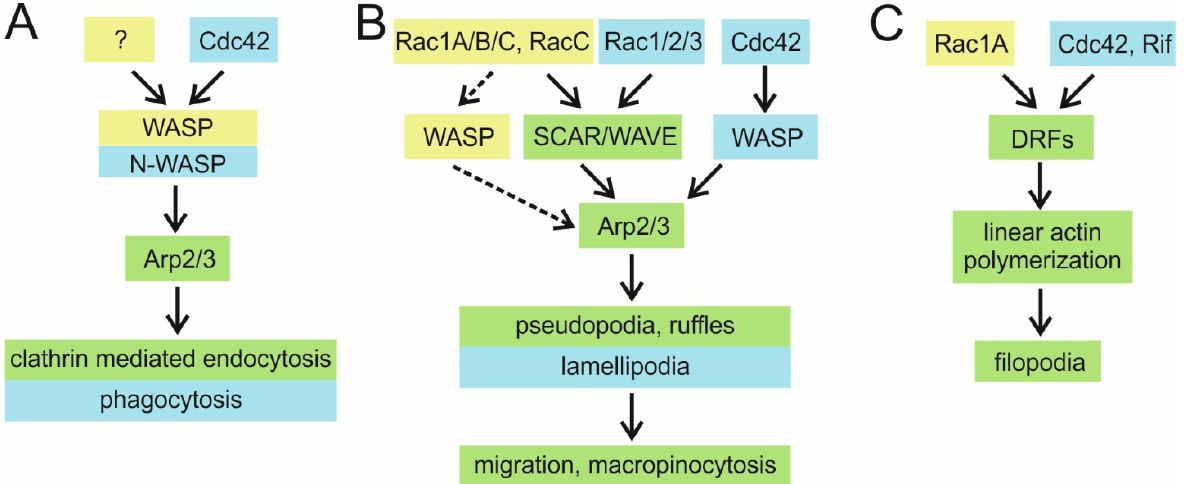
Figure 2. Parallel presentation of major signalling pathways starting from Rac1A/B/C and RacC in Dictyostelium (yellow) and Rac1/2/3 and Cdc42 in mammals (blue) and converging onto the actin cytoskeleton regulation. ( A , B ) Activation of the Arp2/3 complex via WASP family proteins, converging on the clathrin-mediated endocytosis and phagocytosis ( A ), or the protrusion of pseudopodia and macropinocytotic cups ( B ). ( C ) Activation of the DRF-mediated actin polymerization and protrusion of filopodia. The common elements shared by Dictyostelium and mammals are shown in green. The default active state of small GTPases is GTP-loaded.